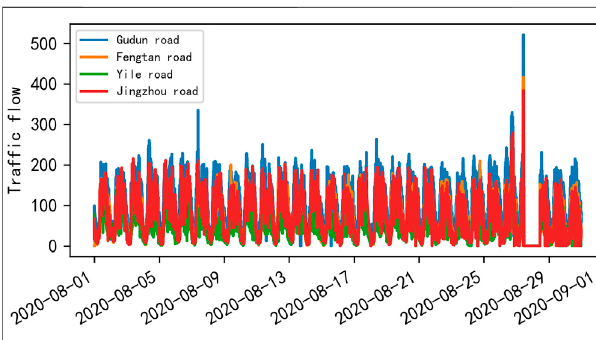
FIGURE 5 | Mean visualization of the traf fi c volume of the four roads on Wenyi Road in 30